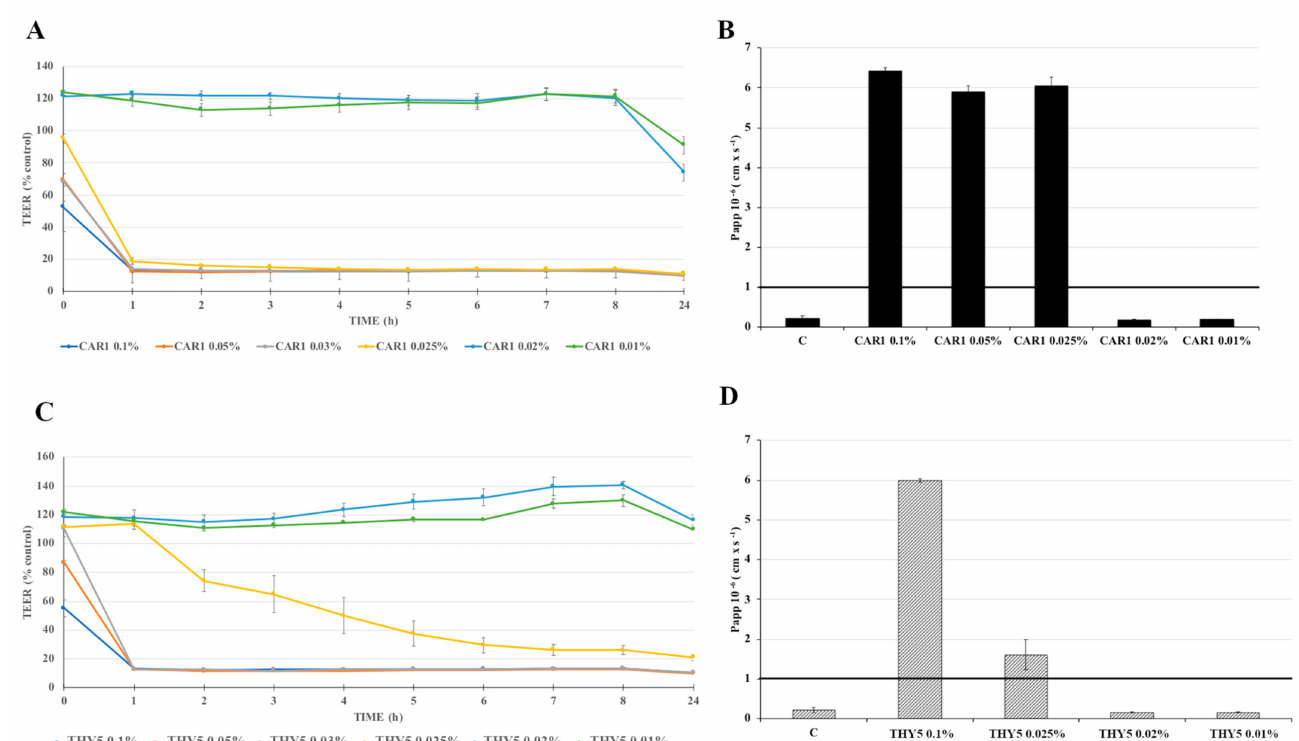
Figure 4. CAR1 and THY5 effects on Caco-2 cells monolayer integrity: Transepithelial electrical resistance (TEER) and phenol red apparent permeability (Papp). Cells were untreated (Control, C) or treated with different CAR1 or THY5 concentrations (0.01–0.1%). TEER values (( A ) for CAR1 and ( C ) for THY5), recorded for up to 24 h, were calculated as the % of C for each timepoint. Phenol red Papp (( B ) for CAR1 and ( D ) for THY5) was measured at 24 h and values are reported as cm s − 1 . A black line set at 1 × 10 − 6 cm s − 1 represents the Papp threshold, indicating destroyed cell monolayer integrity for values above. Values represent the mean ± SD of the two independent experiments, carried out in